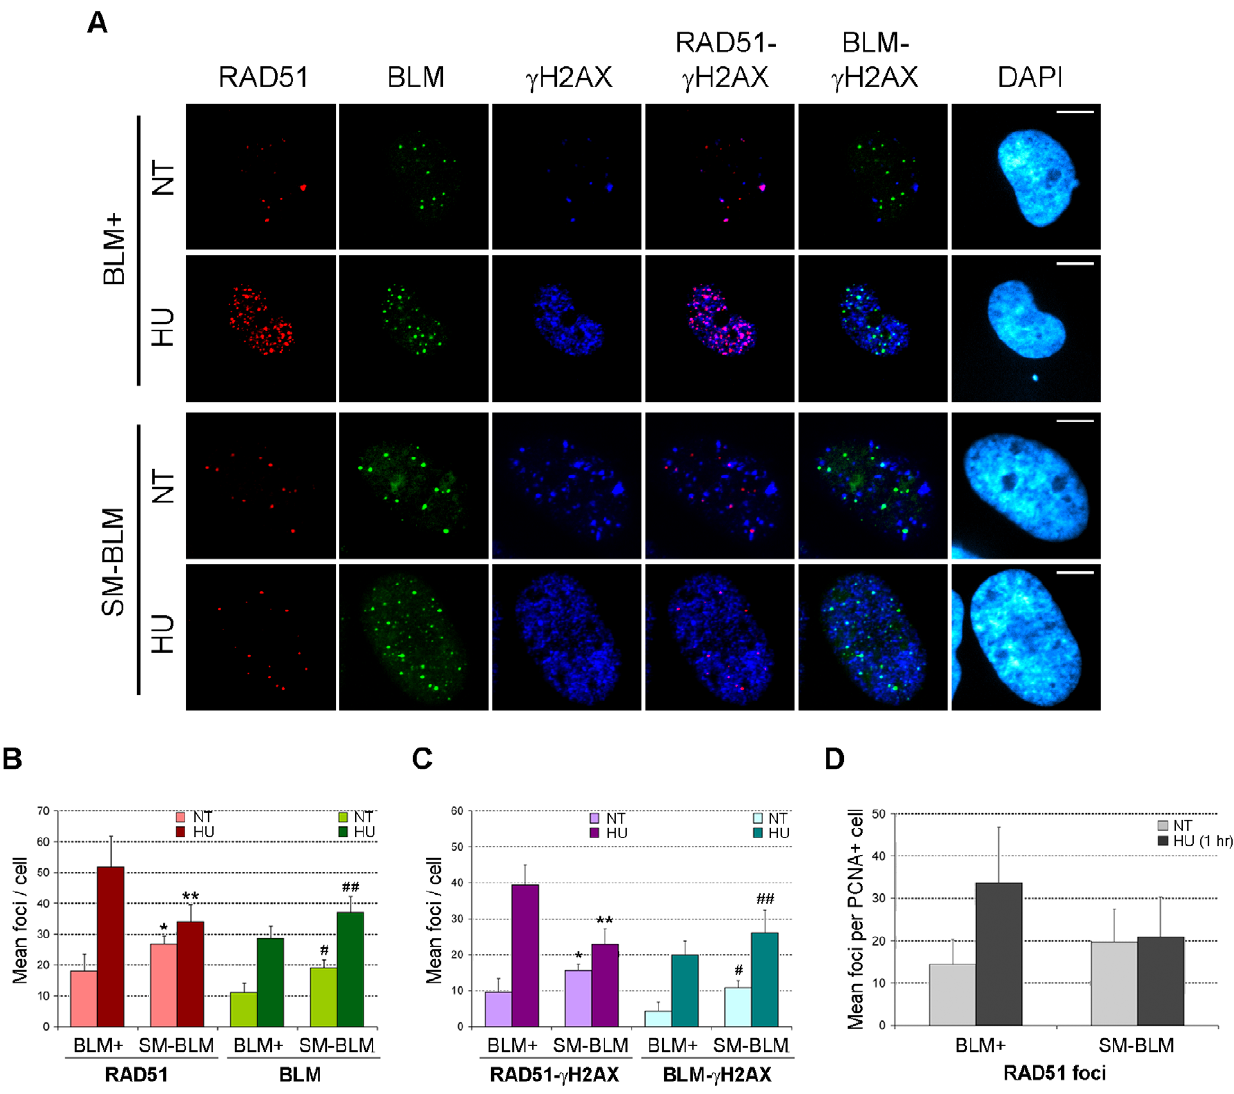
Figure 5. RAD51 has a localization defect in HU-treated SM-BLM cells. (A) Immunofluorescence images of BLM + and SM-BLM cells treated with 0.5 mM HU for 24 h or not treated (NT) and stained for c -H2AX and RAD51. Bars indicate 10 m m. (B) Graphical representation of mean numbers of RAD51 and BLM foci in HU-treated and untreated BLM + and SM-BLM cells. * p =0.09, NT SM-BLM versus NT BLM + ; ** p =0.02, HU-treated SM-BLM versus HU-treated BLM + . # p =0.01, NT SM-BLM versus NT BLM + ; ## p =0.01, HU-treated SM-BLM versus HU-treated BLM + . (C) Graphical representation of mean numbers of colocalized RAD51- c -H2AX and colocalized BLM- c -H2AX foci in HU-treated and untreated BLM + and SM-BLM cells. * p , 10 2 3 , NT SM-BLM versus NT BLM + ; ** p , 10 2 3 , HU-treated SM-BLM versus HU-treated BLM + ; # p , 10 2 3 , NT SM-BLM versus NT BLM + ; ## p =0.02, HU-treated SM-BLM versus HU-treated BLM + . Bars in (B) and (C) represent the average foci in three independent experiments of three BLM + and three SM-BLM clones. Error bars represent the standard deviations of the combined data. (D) Graphical representation of means numbers of RAD51 foci in untreated cells or cells treated with 10 mM HU for 1 h. RAD51 foci were counted in cells that stained positively with PCNA antibodies. Bars represent the average foci in two independent experiments of two BLM + and two SM-BLM clones. Error bars represent the standard deviations of the combined data. interaction between RAD51 and SUMOylated BLM. To test this and unmodified BLM and analyzed bound proteins by Western hypothesis, we assayed for possible noncovalent interactions blot with anti-BLM antibodies. Consistent with previous find- between RAD51 and SUMO and also for possible effects of ings [20], unmodified BLM bound specifically to RAD51- covalent SUMOylation of BLM on its interactions with RAD51 coated beads, confirming that BLM and RAD51 interact directly (Figure 6). In an in vitro binding assay, more RAD51 bound to (Figure 6B, left panel). SUMO-2–modified BLM also bound SUMO-coated beads than to controls beads (Figure 6A), showing specifically to RAD51-coated beads (Figure 6B, right panel). To that RAD51 binds equally well to both SUMO-1 and SUMO-2. evaluate the effect of SUMO-2 modification on BLM’s interaction with RAD51, the results of the binding assays were analyzed interaction with RAD51, we incubated RAD51-coated beads with quantitatively. This analysis revealed that, whereas the ratio of either unmodified BLM or with a mixture of SUMO-2–modified SUMO-2–modified to unmodified BLM in input fractions and